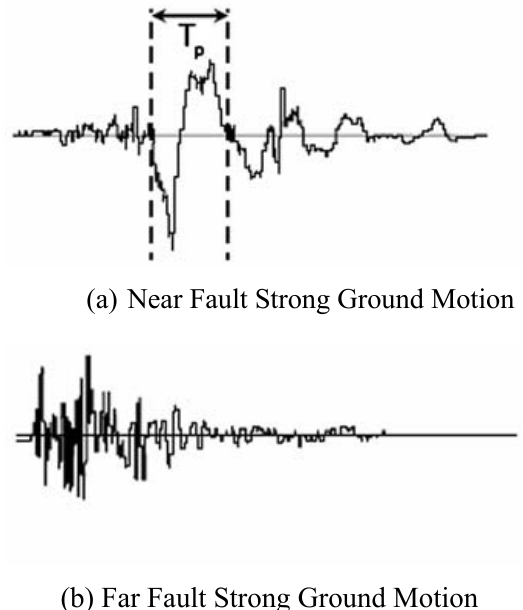
two different strong ground motion velocities. Fig. 1. The time-histories of Fig. 1. The time-histories of